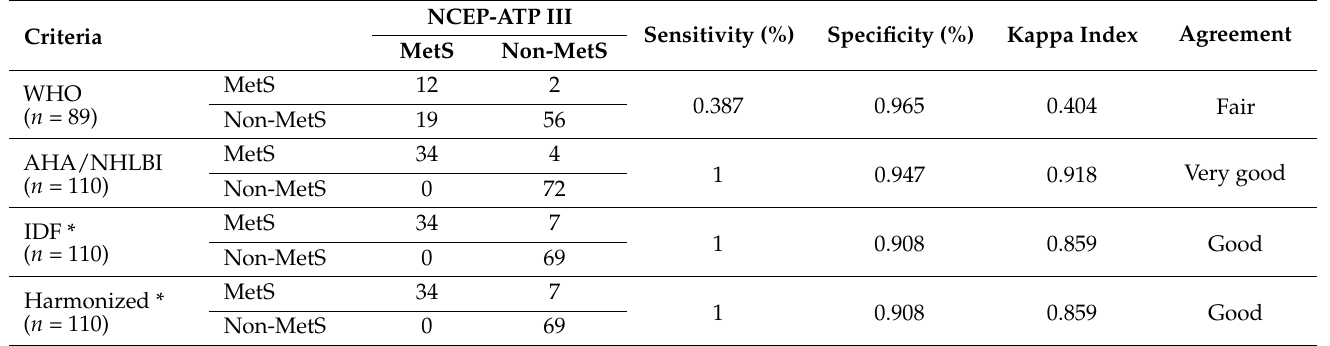
Table 4. Agreement and disparity in diagnosis of metabolic syndrome using the WHO, NCEP ATP III, AHA/NHLBI, IDF, and Harmonized criteria.